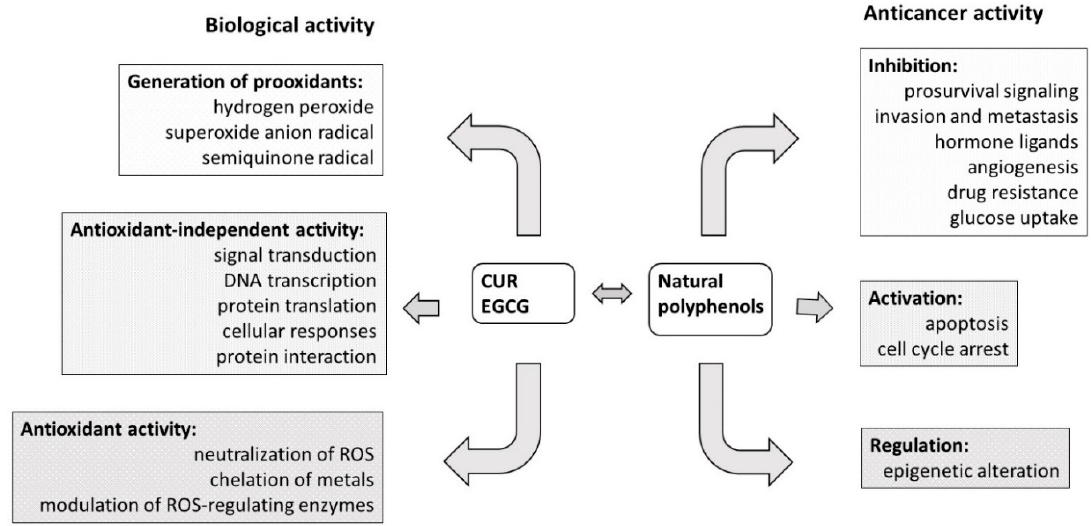
Figure 3. Mechanism of the biological and anticancer activities of curcumin (CUR) and ( − )-epigallocatechin-3- O -gallate (EGCG) as the natural polyphenols (based on Zhou et al. [31]).